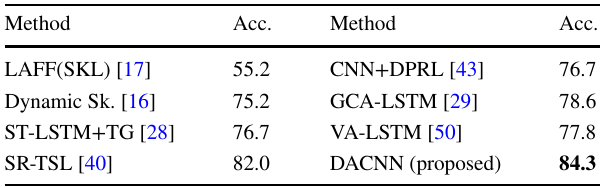
The best result (bold) is according to a two-valued t-test at a 5% sig- nificance